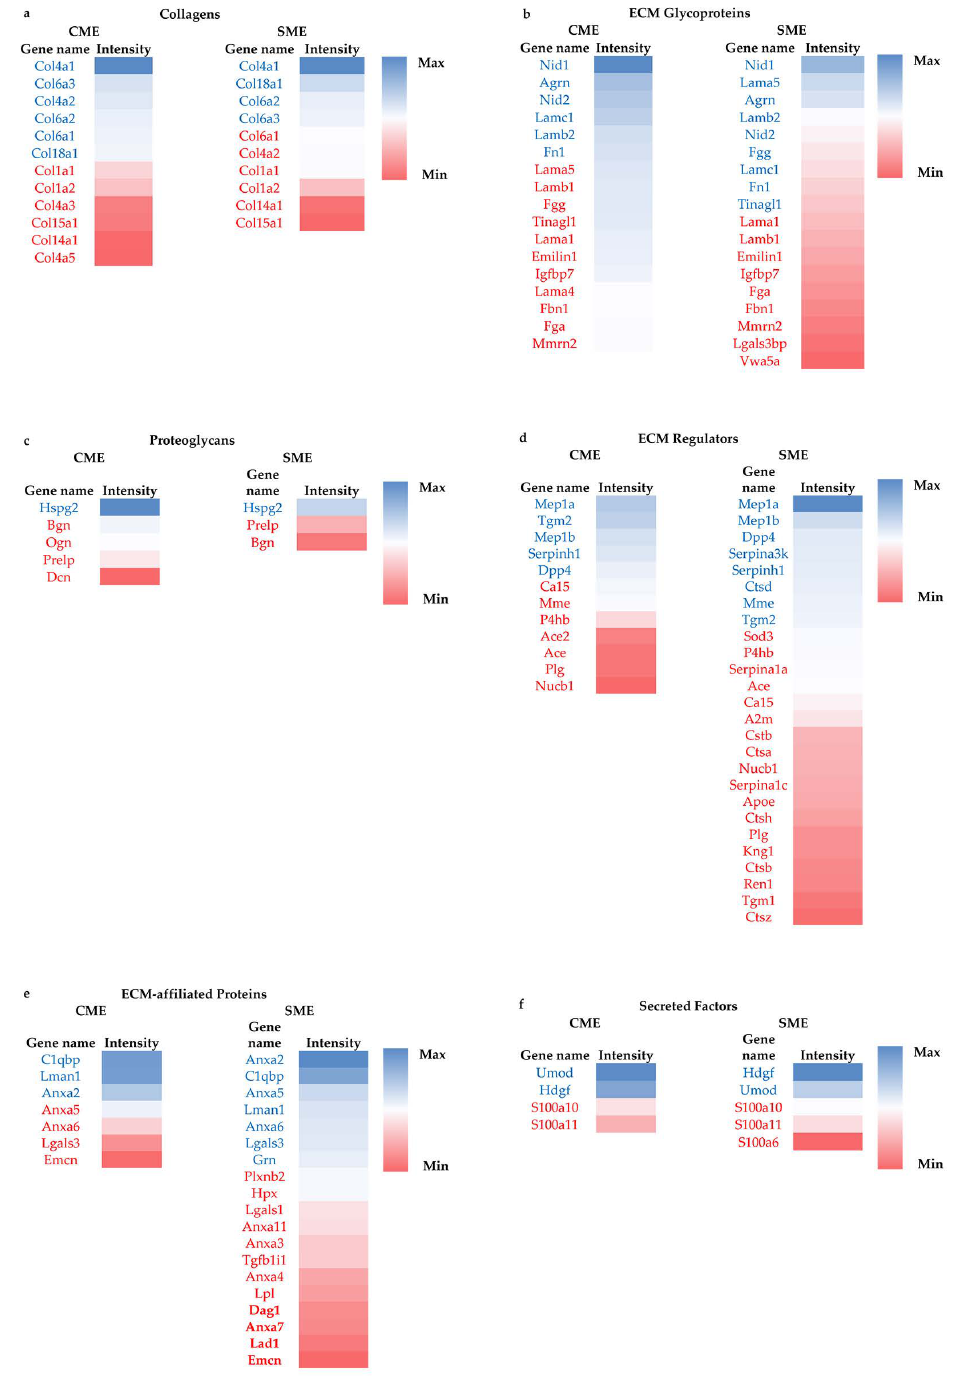
Figure 5. Heatmap of abundance of quantifiable matrisome proteins in the products of the CME and SME methods of sample preparation. Color coding in the heatmap depicts the variation between the maximum (coded in blue tones) to minimum (coded in red tones) observed LFQ intensity for each matrisome category and protein extraction method. The protein names shown by blue and red fonts are expressed above and below the average LFQ values in each matrisome category,